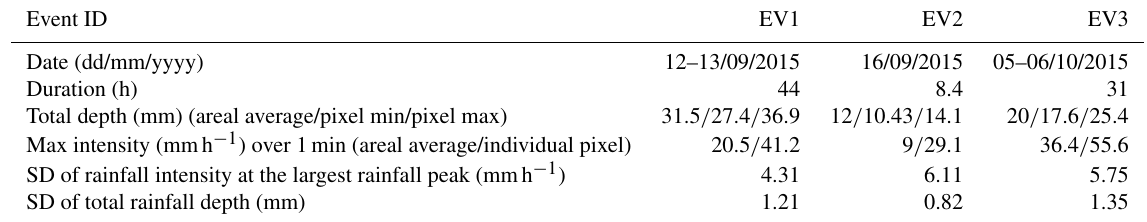
Table 1. Main characteristics of selected rainfall events and standard deviation (SD) of the rainfall intensity at the largest rainfall peak and the total rainfall depth of the three rainfall